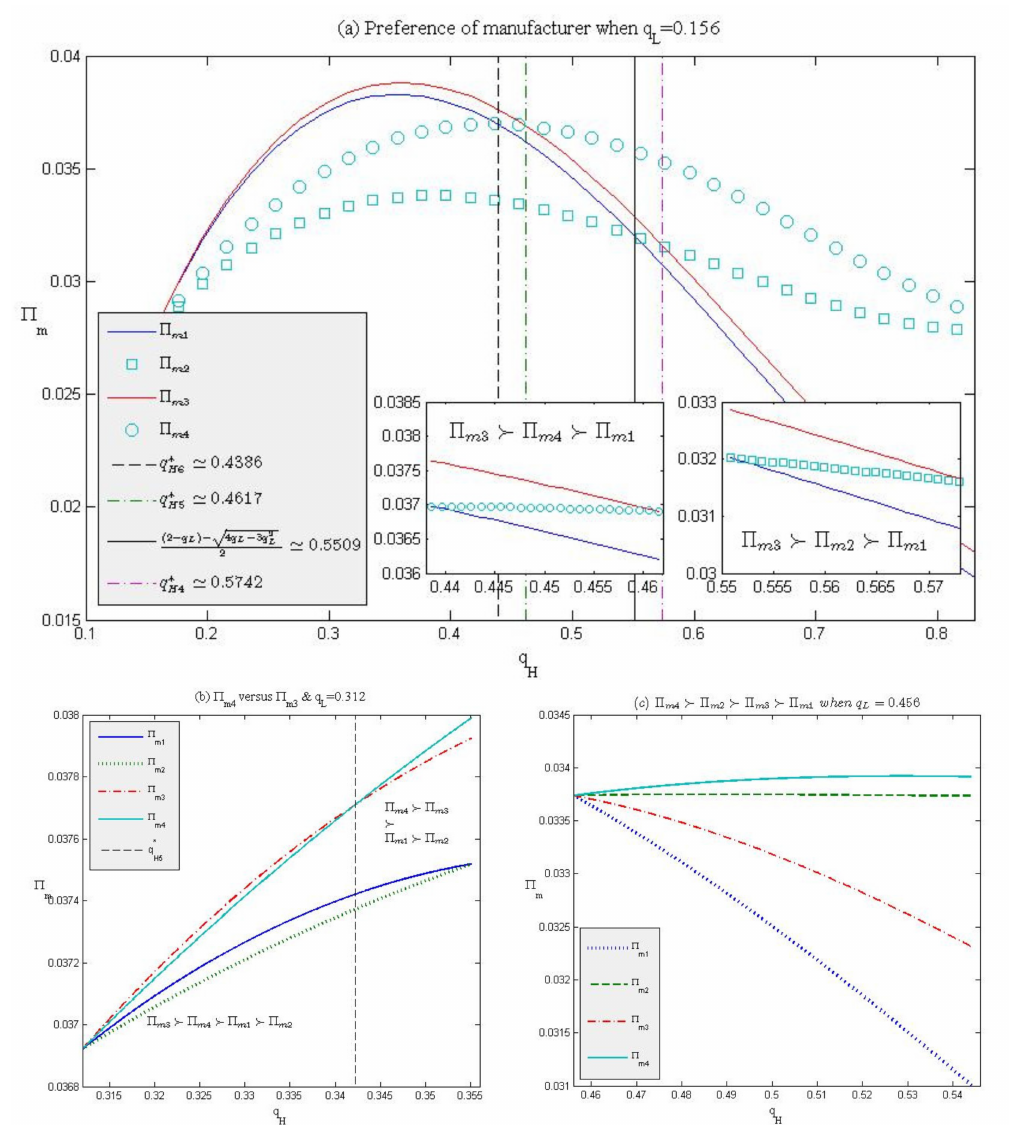
Figure 8. Manufacturer’s channel structures in different mass